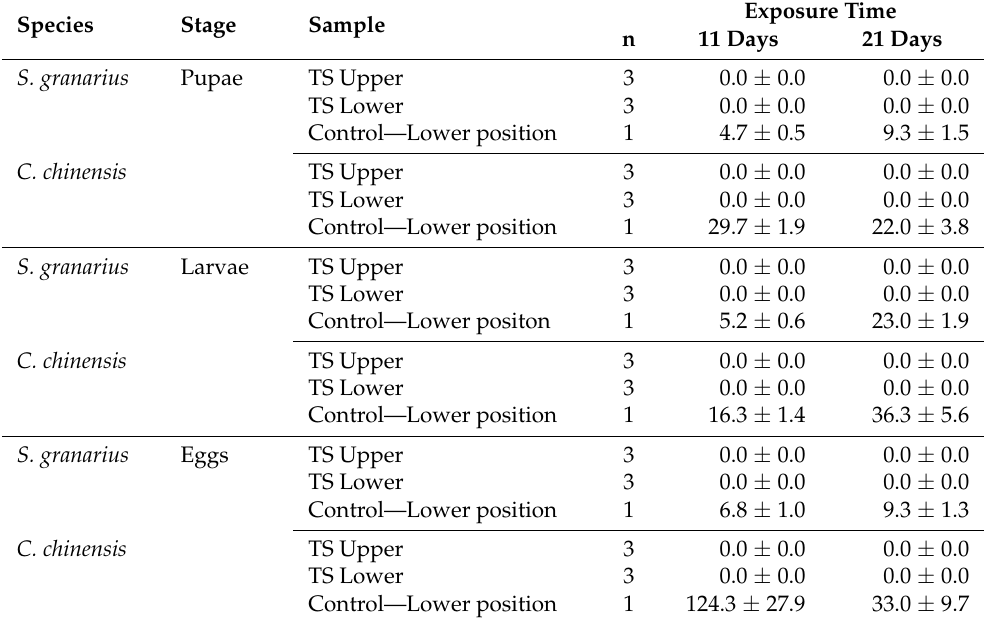
Table 7. Field efficacy (Average No. of adults emerged following their treatment in subadult stages; Av. No. ± SE) of controlled nitrogens atmospheres (below 1% of oxygen) on eggs, larvae and pupae of the tested species in metal silos under two exposure regimes of 11 or 21 days. For each treated silo units (n = 3 silos) 4 bio-assay-dishes with insects were